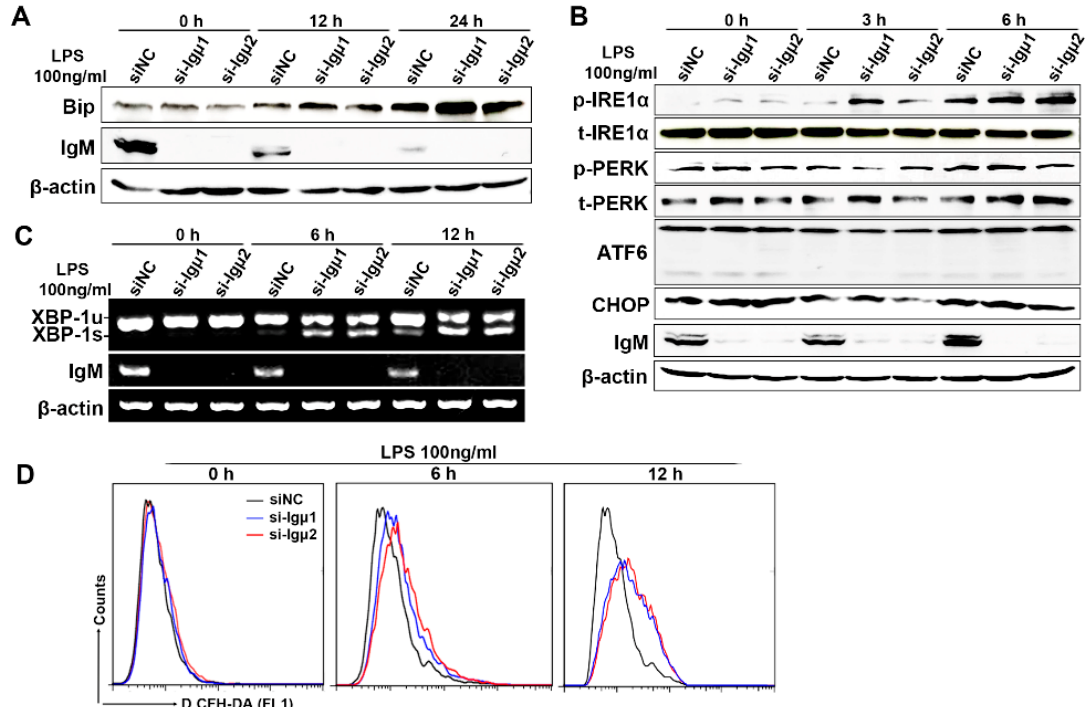
Figure 6. IgM knockdown promoted the IRE1 α branch of the ER stress pathway through regulating Bip expression. RAW264.7 cells were transfected with IgM siRNA (si-Ig µ ) and control siRNA (siNC) for 36 h before exposure to LPS (100 g/mL) for the indicated times. ( A ) Intracellular Bip protein expression was upregulated after IgM knockdown by Western blot analysis. β -actin acted as an internal control. ( B ) Enhanced effects of IgM knockdown on phosphorylation of IRE1 α but not PERK, ATF6, and CHOP were shown by Western blot analysis. ( C ) RT-PCR analysis showing the Expression of XBP1u mRNA and XBP1s mRNA. IgM as positive control and β -actin as an internal control. ( D ) Representative flow cytometric histograms showing ROS production measured by the H2DCF-DA probe in RAW264.7 cells. blue line, si-Ig µ 1; red line, si-Ig µ 2; black line, siNC as control siRNA. 4. Discussion In the present study, we extended previous findings and demonstrated IgM expres- sion in macrophages of mice under hemostasis conditions, especially the macrophages of B-cell deficient mice ( μ MT mice), and further revealed that the repertoire features of IgM variable region sequences exhibited individual-specific effects using next-generation se- quencing. More importantly, we identified for the first time that IgM interacted with Bip